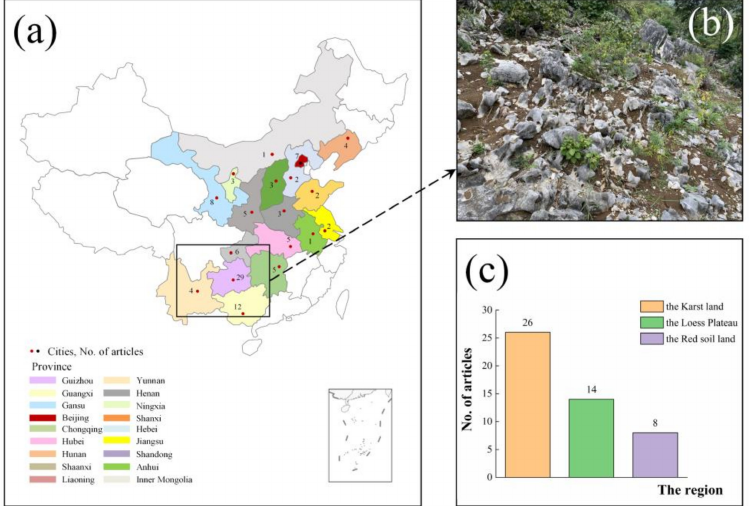
Figure 6. ( a ) The spatial distribution of this study in the provinces of China, where the red dots represent cities in the province (these cities are the main cities in the province), and the numbers near them indicate the number of documents from this province; ( b ) a karst landscape in southern China; ( c ) the number of studies in the three main regions of this research field in